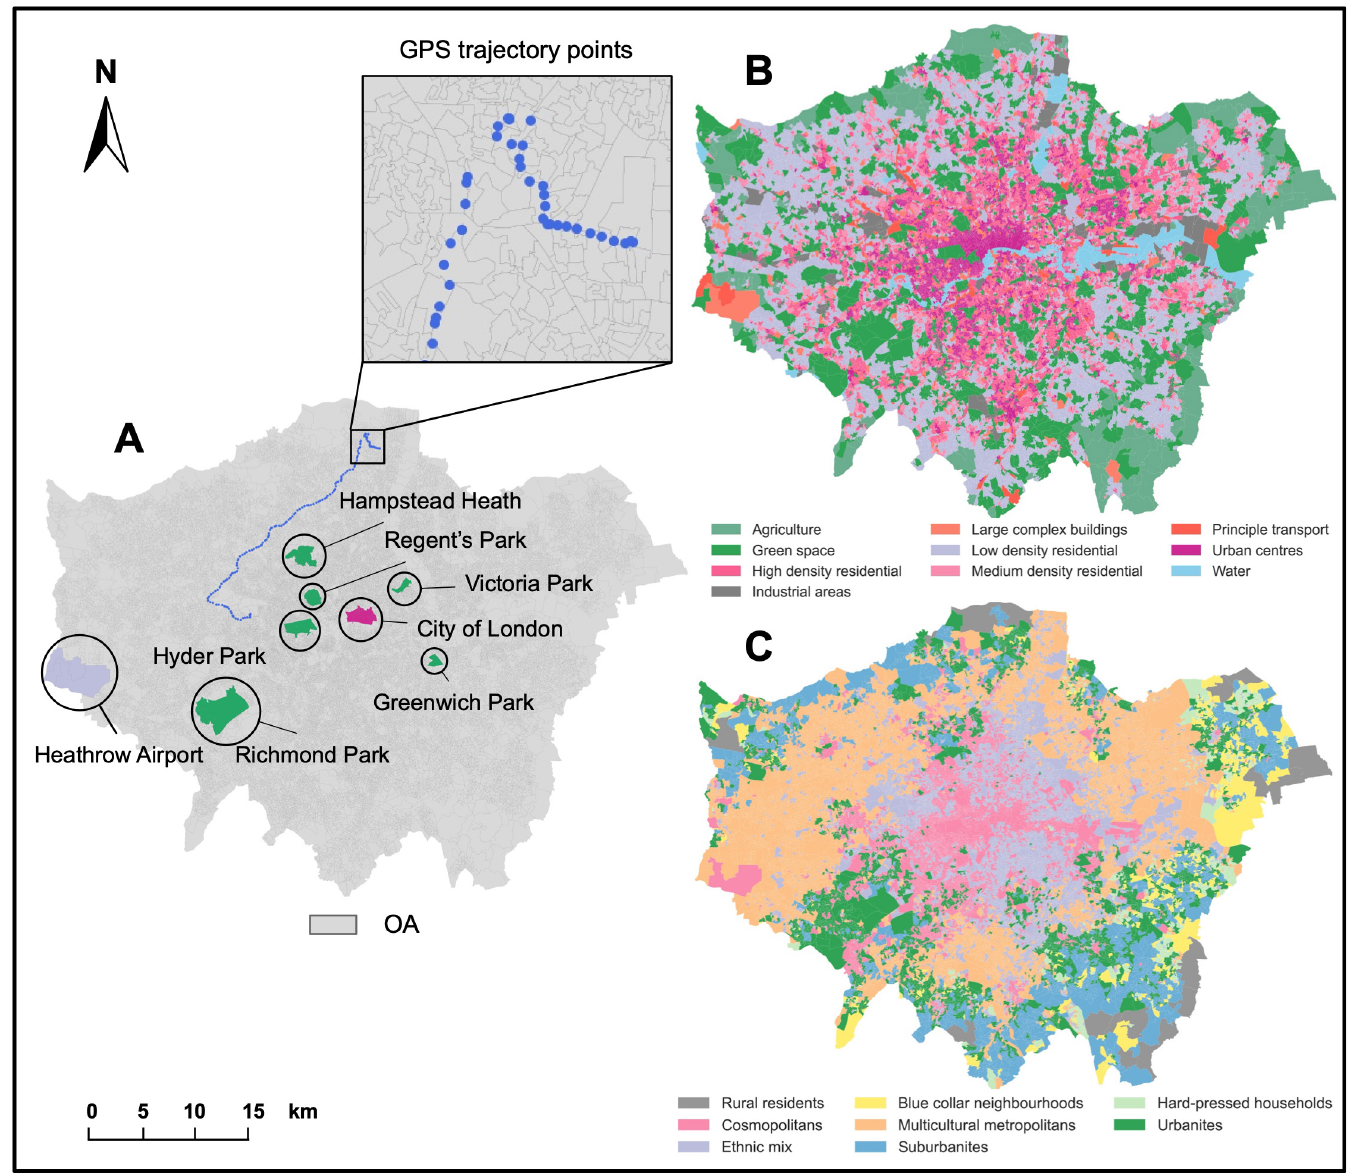
Fig 2. The mobile phone GPS trajectory sample and urban characteristic distribution at OA-level in Greater London. Map A shows a sample user’s GPS trajectory without the start and end points; Map B shows the distribution of OAs’ land use in ten types (we plot each OA in one land use represented by the maximum land use acreage in ten types). Map C shows the eight supergroups of OA socio-demographic classification. (Geographical boundary data source: Office for National Statistics licensed under the Open Government Licence v.3.0. Contains OS data © Crown copyright and database right 2022. Contains National Statistics data © Crown copyright and database right